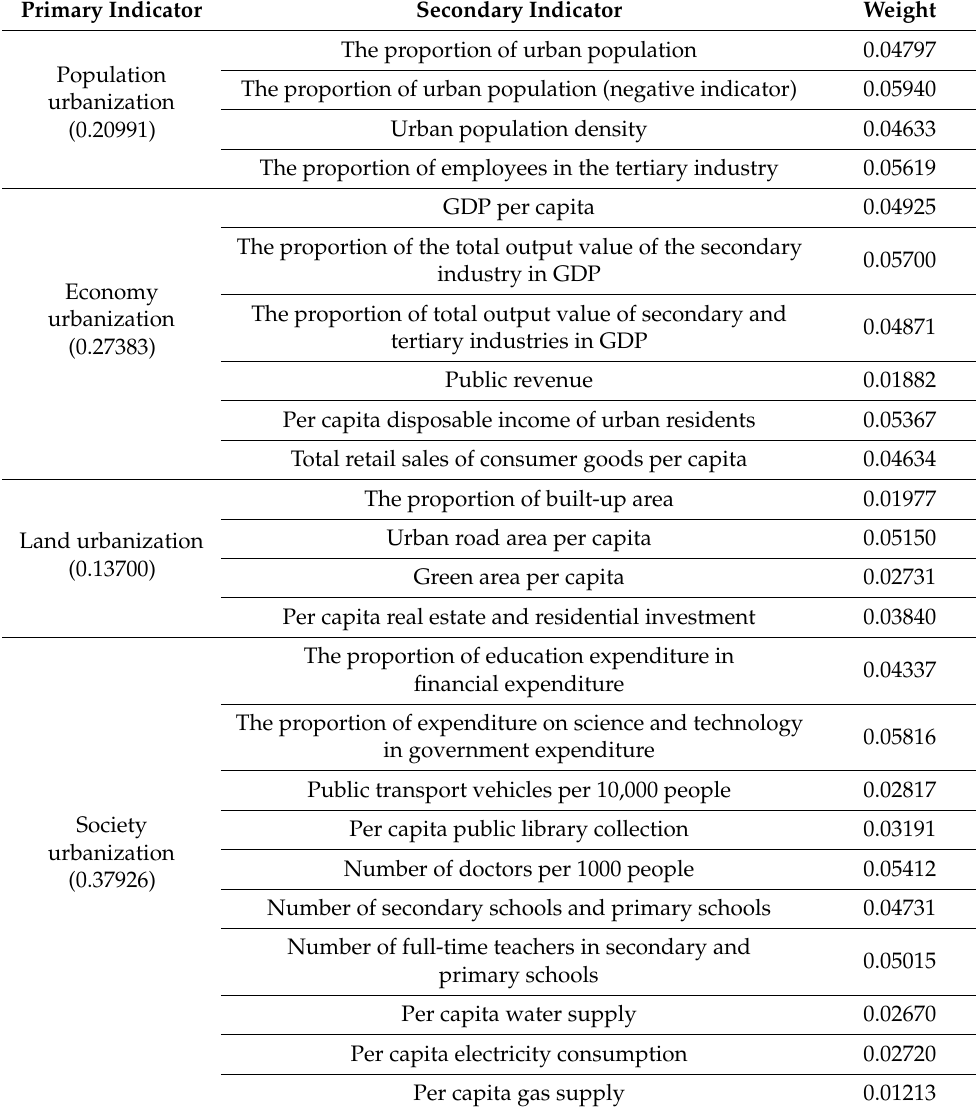
Table 1. New-urbanization indicator